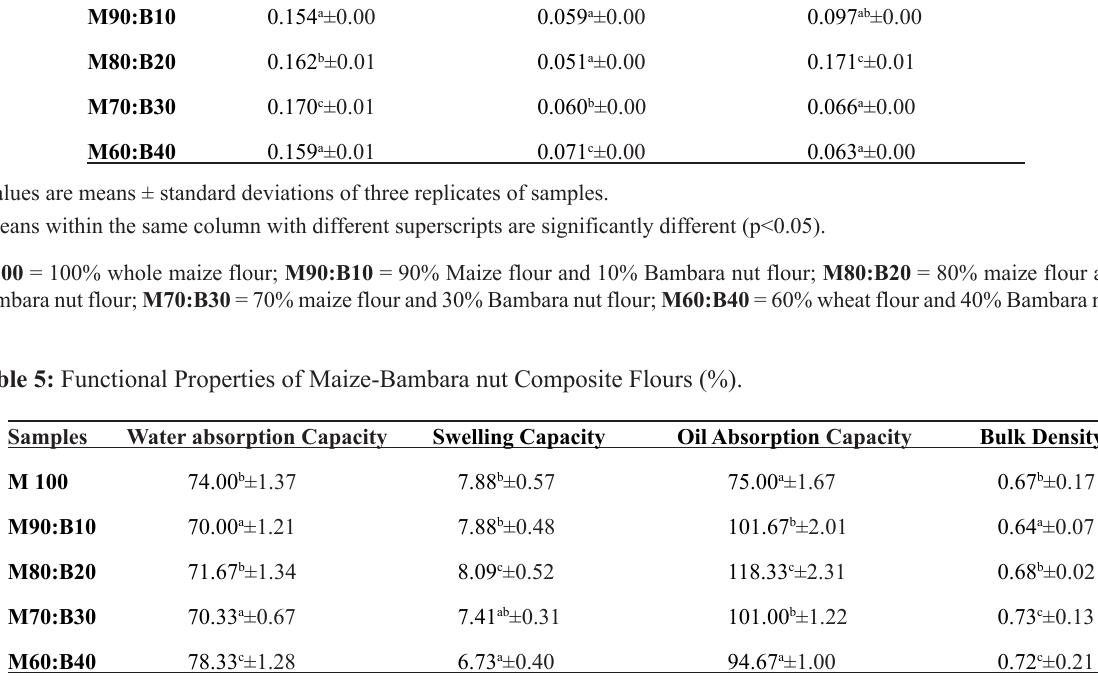
* Values are means ± standard deviations of three replicates of samples. *Means within the same column with different superscripts are significantly different